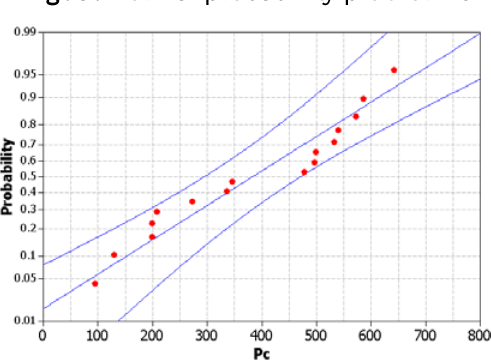
Fig. 7. Normal probability plot for Ra Fig. 8. Normal probability plot for Fc